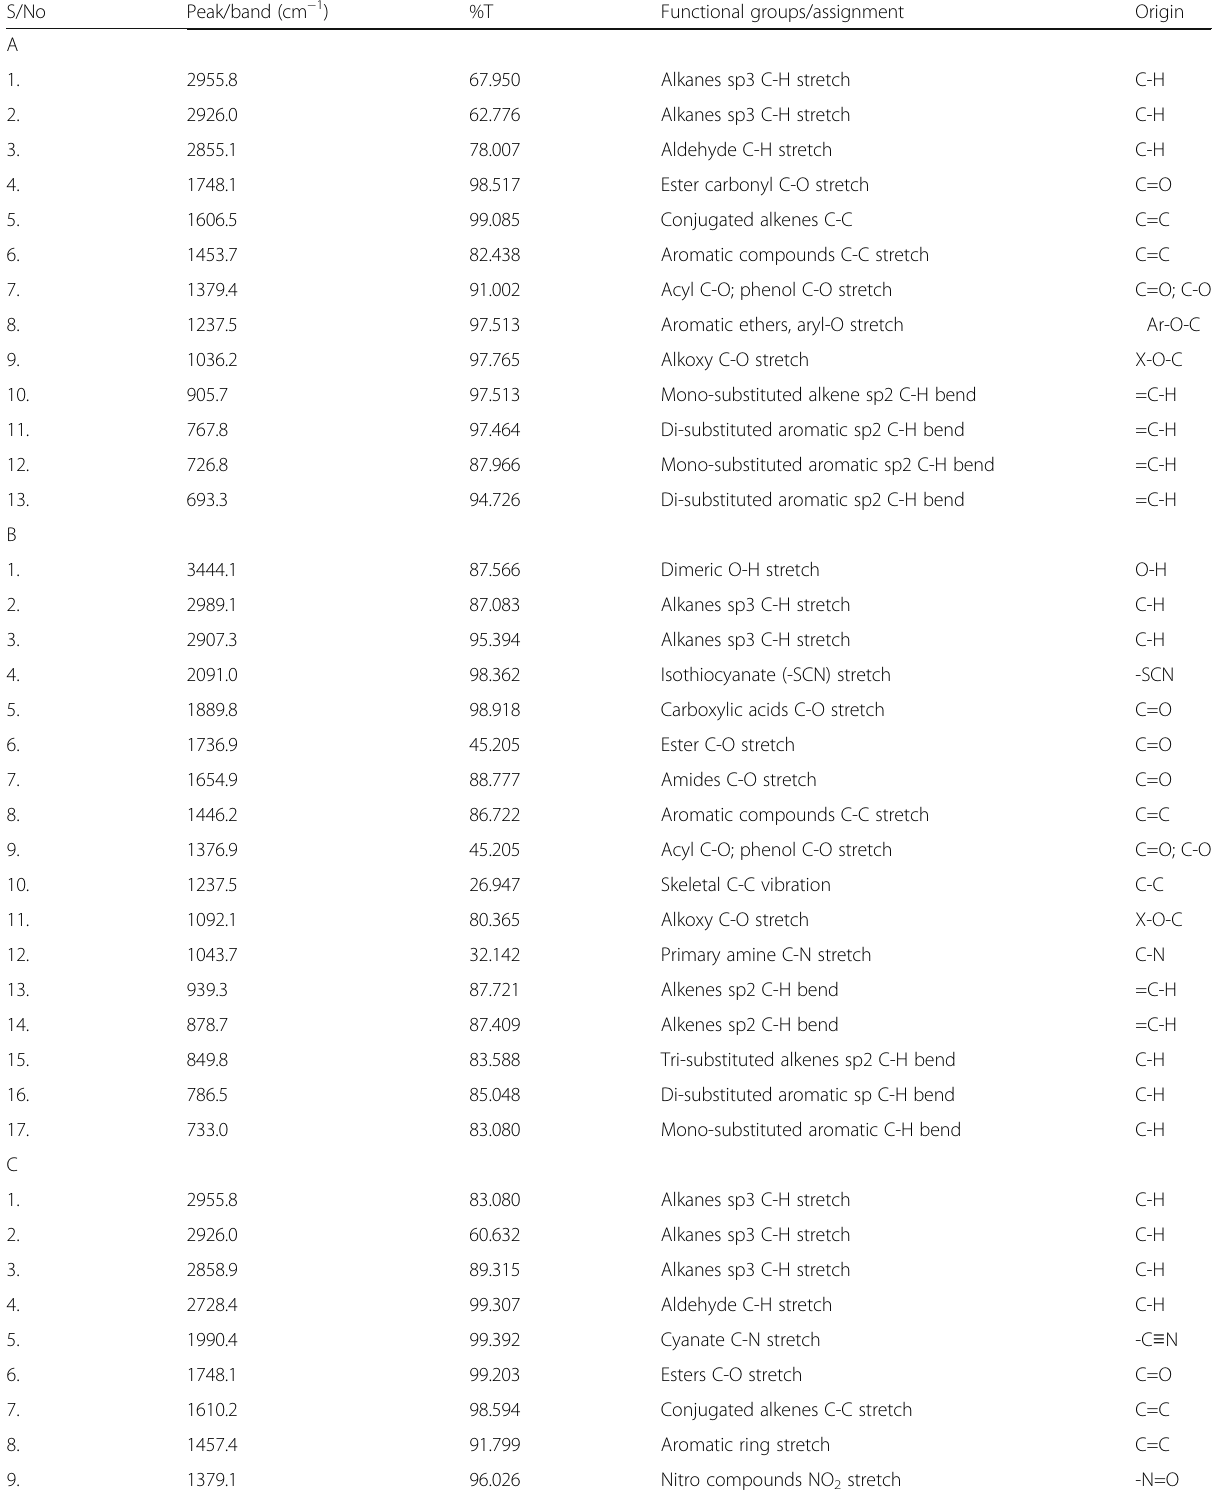
Table 5 FT-IR spectra peak values of (A) petroleum ether extract of A . occidentale , (B) ethylacetate extract of A . occidentale , (C) n - hexane extract of P . guajava , (D) chloroform extract of P . guajava , (E) ethylacetate extract of P . guajava , and (F) ethylacetate extract of T .